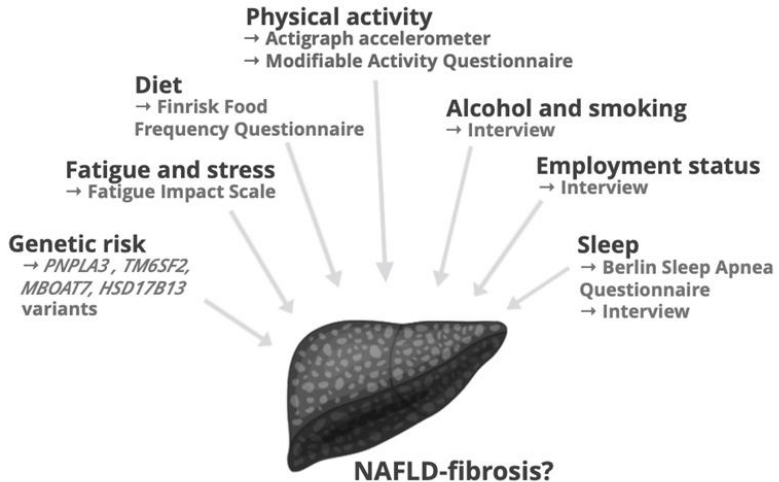
Figure 1. An overview of lifestyle and genetic factors investigated in the study. Abbreviations: HSD17B1 , 17- β hydroxysteroid dehydrogenase; MBOAT7 , membrane bound O-acyltransferase domain containing 7; NAFLD, non-alcoholic fatty liver disease; PNPLA3 , patatin-like phospholipase domain-containing protein 3; TM6SF2 , transmembrane 6 superfamily member